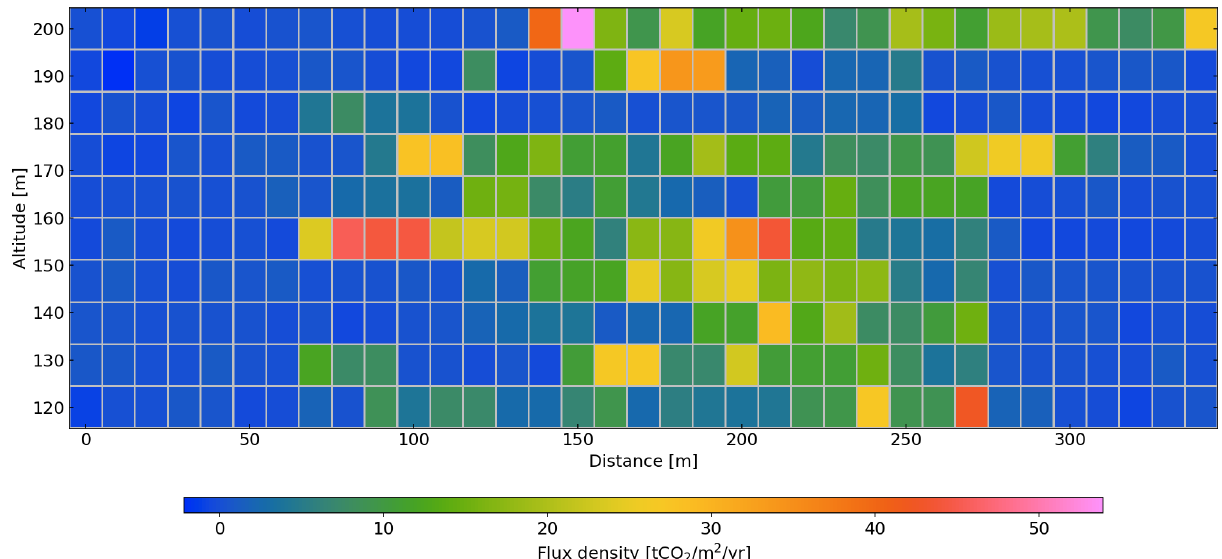
Figure 9. CO 2 mass flux density perpendicular to the plume cross-section computed from the measurements of two flights downwind of the ExxonMobil natural gas processing facility in Großenkneten 40km west of Bremen, Germany, 10 April 2020. The x axis corresponds to the distance from the west-most point of the flight